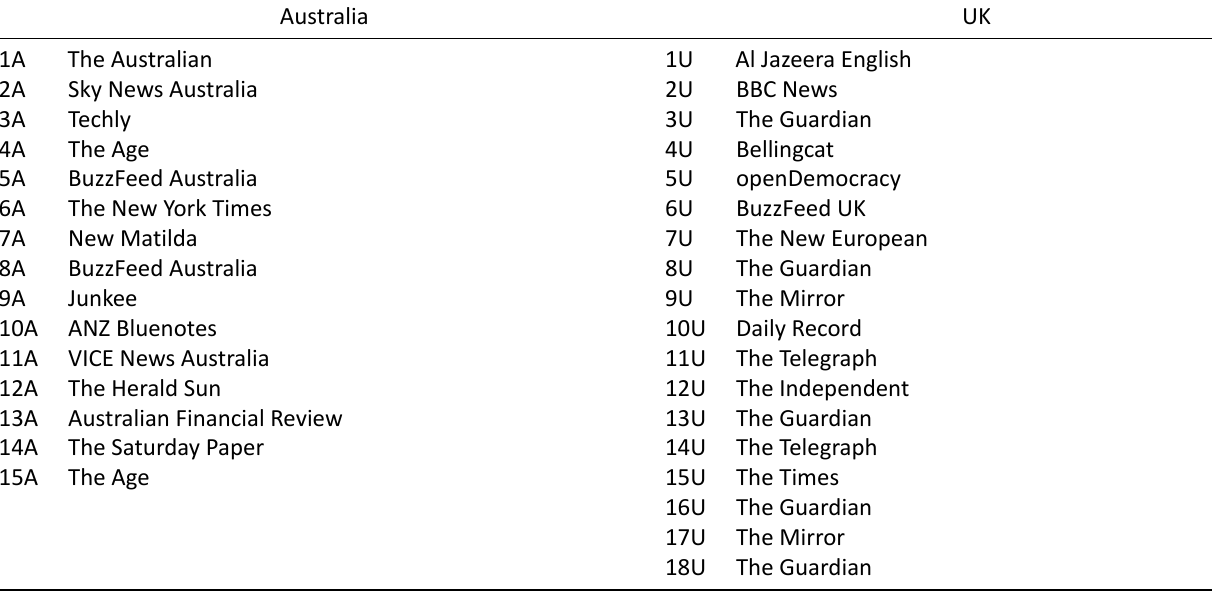
Table 1. Sample of interviewees including media outlet and position